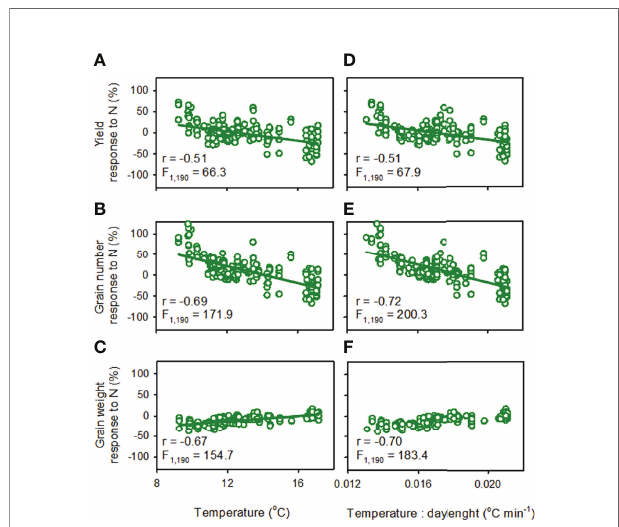
FIGURE 5 | Response to nitrogen fertilisation of spring wheat (A, D) yield, (B, E) grain number and (C, F) grain weight as a function of (A – C) mean temperature during the critical period and (B, E, F) temperature: daylenght ratio. Response to nitrogen is: 100 · (X N -X 0 )/X 0 where X is the trait (yield, grain number, grain weight), subscript N indicates fertilised (100 or 200 kg N ha -1 ), and subscript 0 indicates unfertilised control. The critical period is from 300°Cd before to 100 °Cd after fl owering (base temperature = 4.5°C). Lines are least squares regressions, all with p <